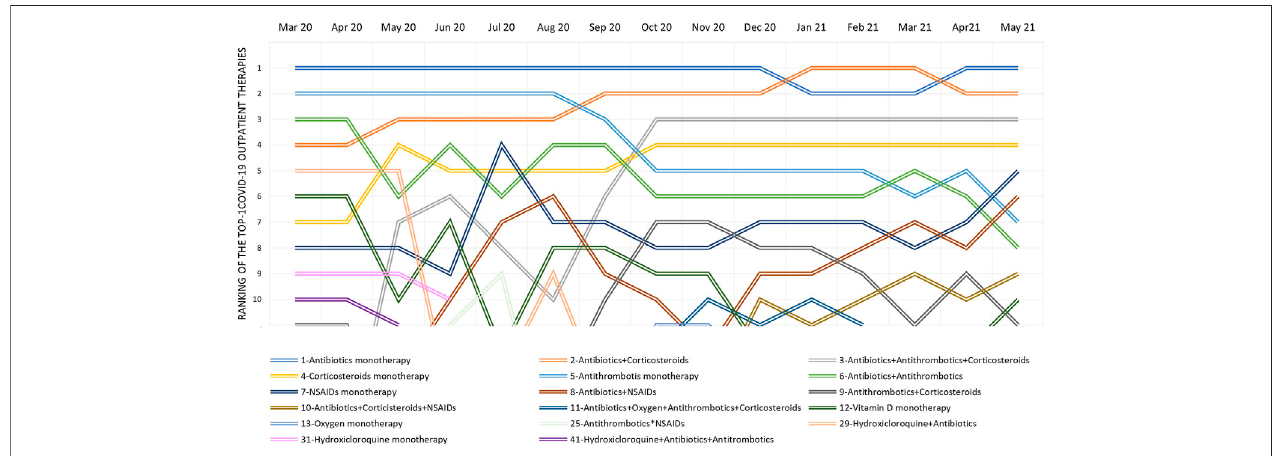
FIGURE 3 | Ranking of the top 10 COVID-19 outpatient therapies during the period from March 2020 to February 2021 and variation by calendar month. Note: In the legend, COVID-19 outpatient therapy and the rank observed considering the entire study period are reported.